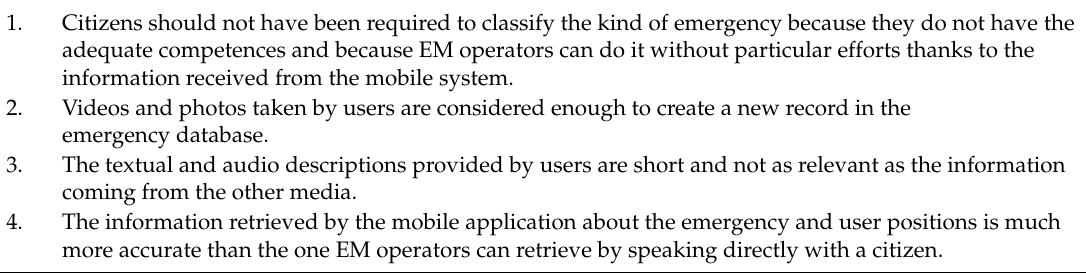
Table 4. Summary of experts’